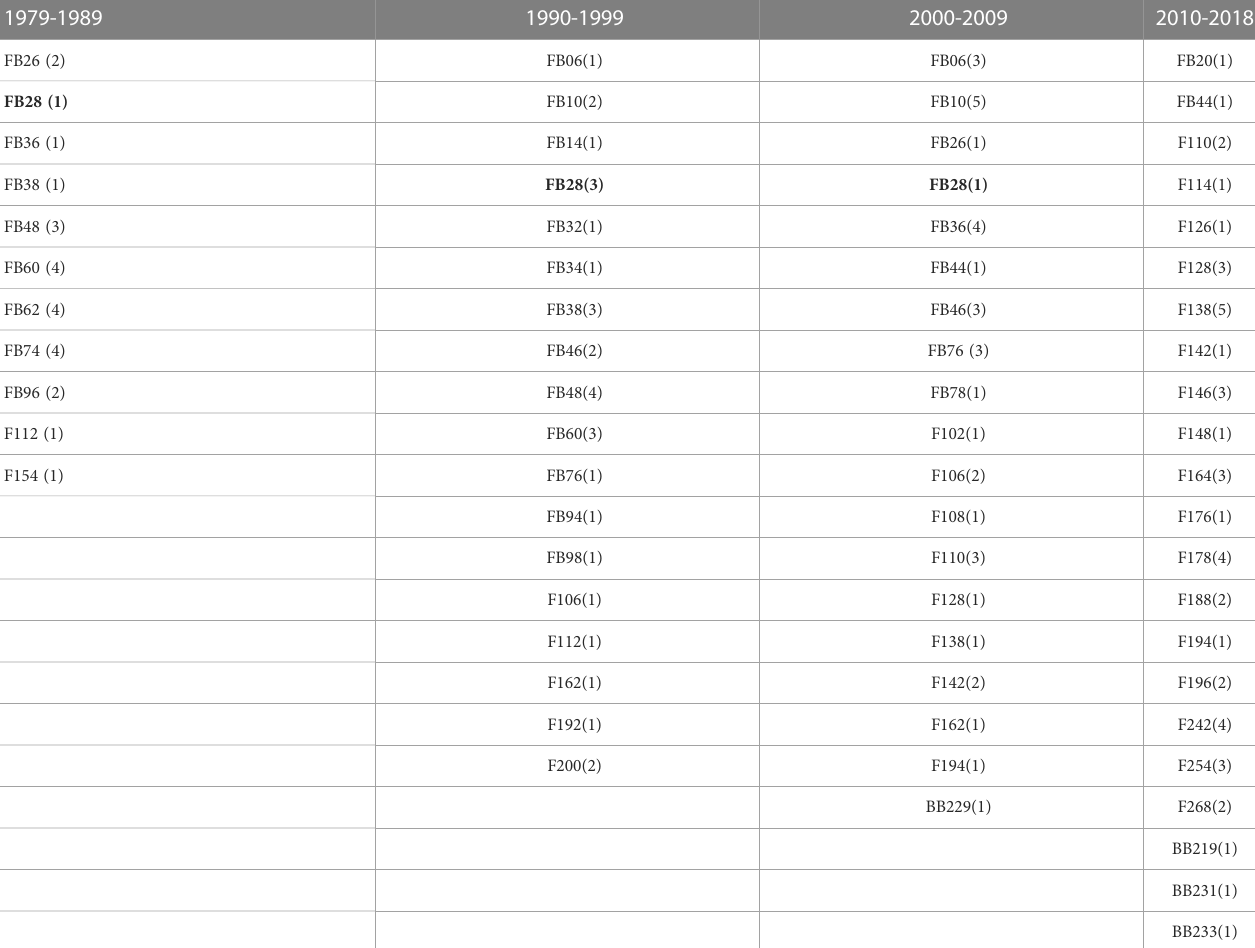
TABLE 3 Reproductive contribution of individual males in the Sarasota Bay community by